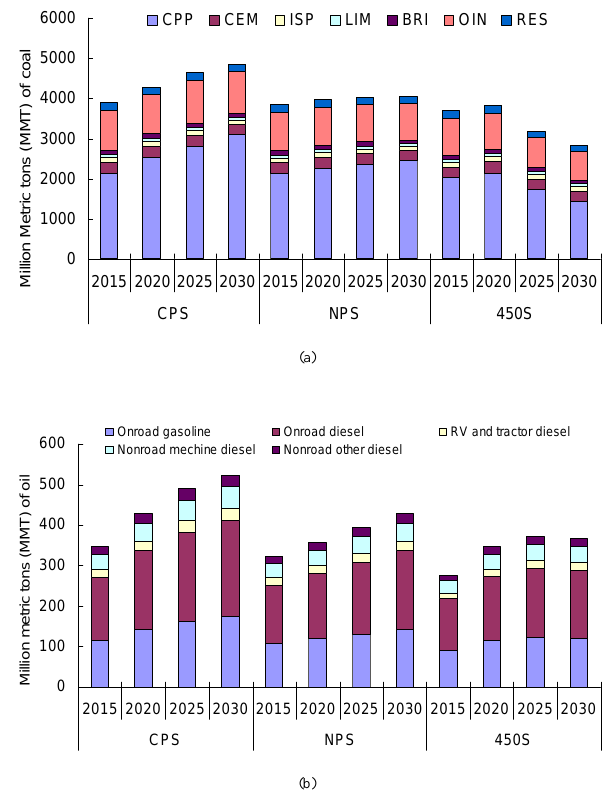
Figure 1. Projection of China’s energy use for 2015, 2020, 2025 and 2030. (a) Coal consumption by sector and scenario; and (b) oil consumption of transportation by vehicle type and